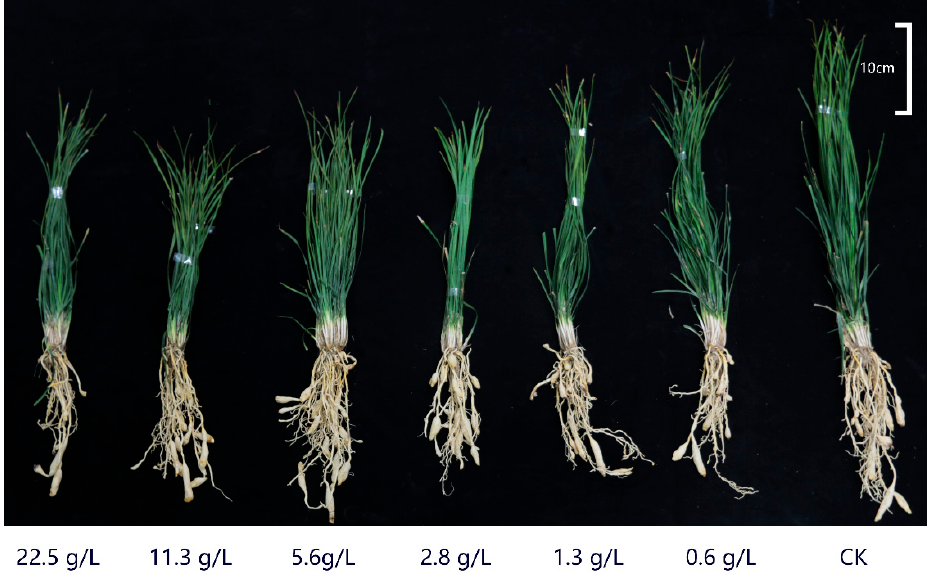
Figure 2. Comparison of whole O. japonicus plants after spraying different concentrations of paclobutrazol.